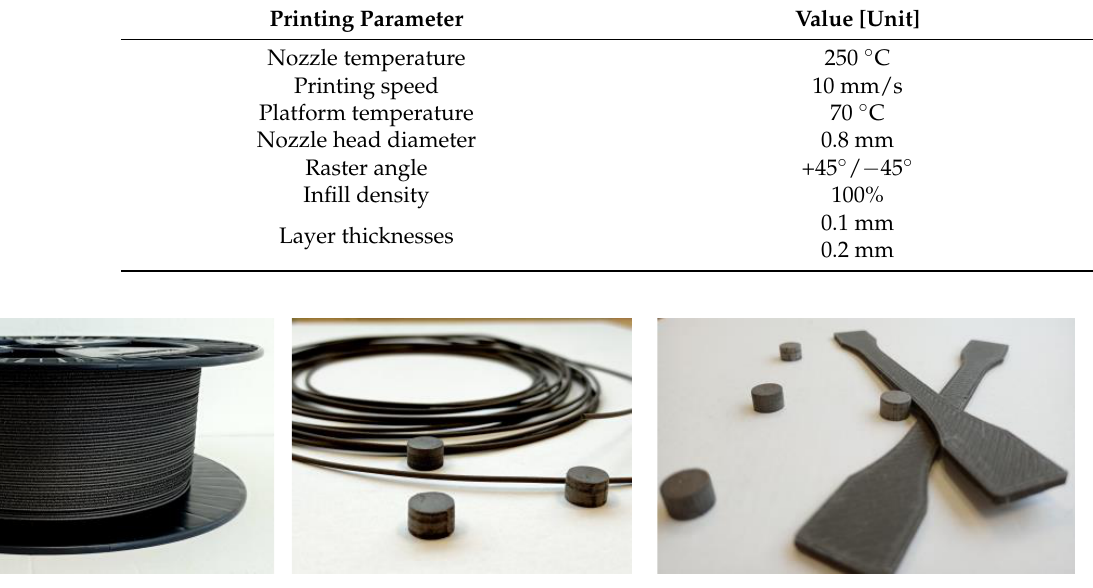
Figure 2. Extruded filament for FDM and FDM-printed samples in the form of cylinders and dog- bone-shaped test tubes.